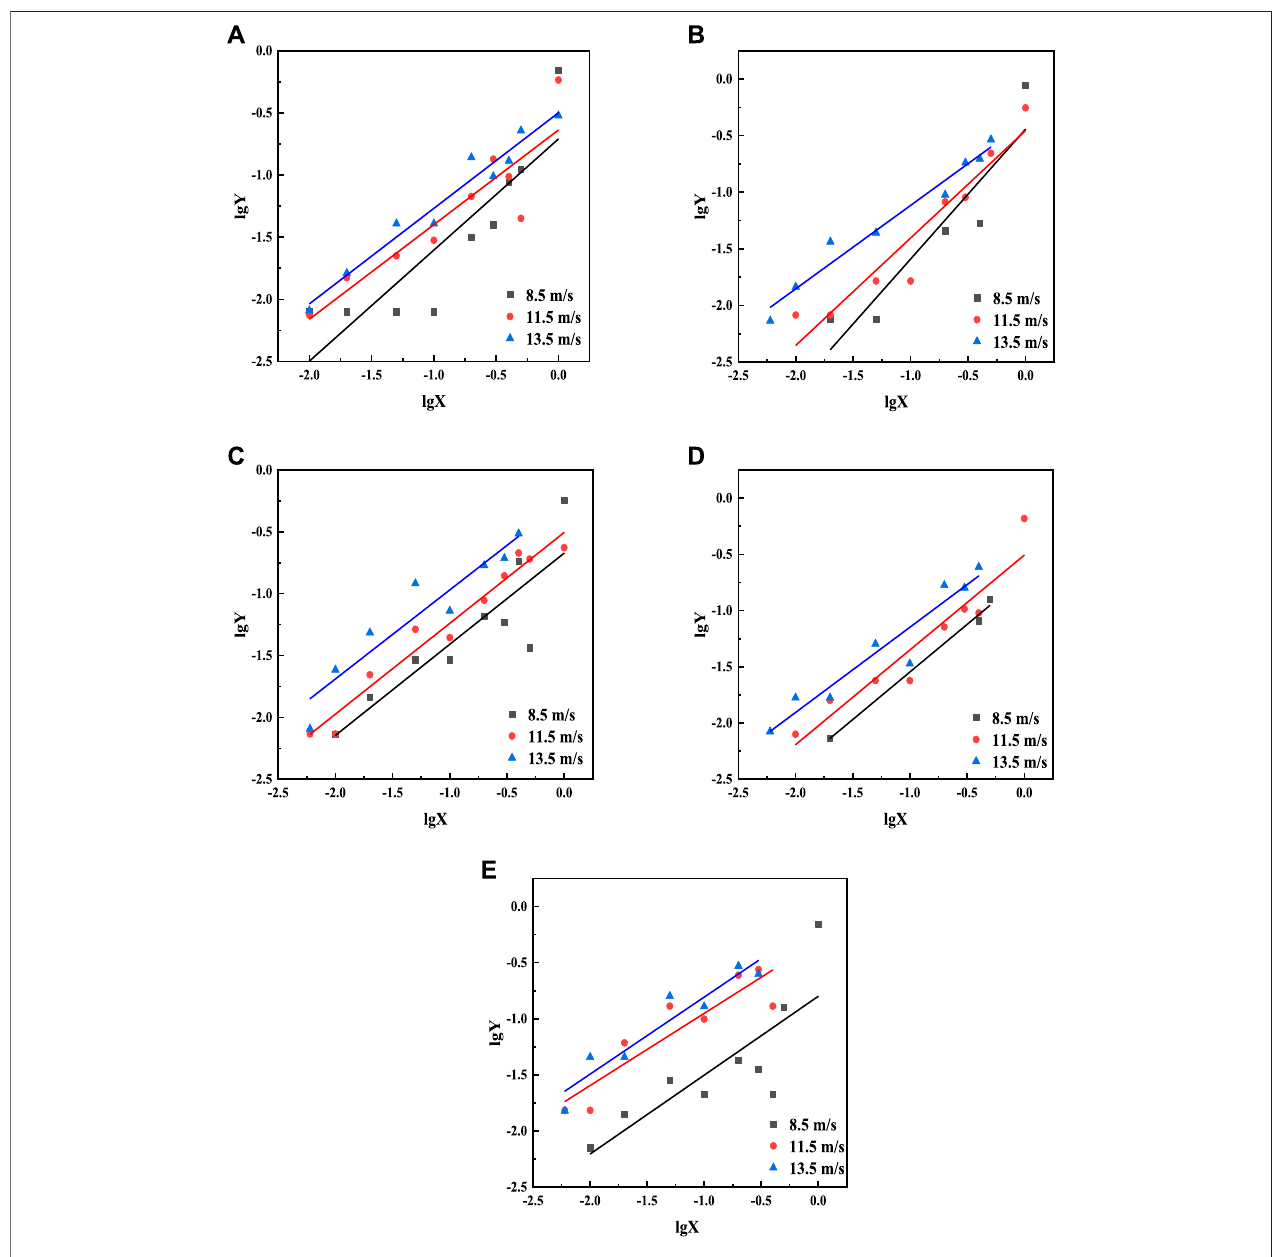
FIGURE 9 | lgY – lgX curves: (A) 25 ° C, (B) 200 ° C, (C) 400 ° C, (D) 600 ° C, and (E) 800 ° C.